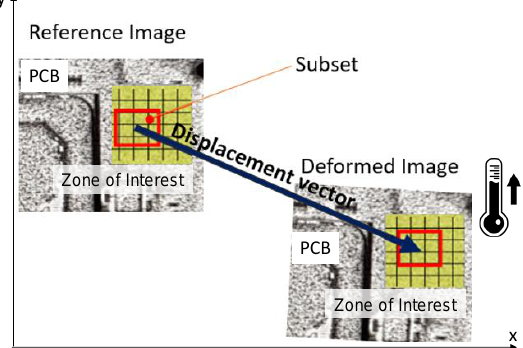
Figure 1. The principle of the DIC technique.